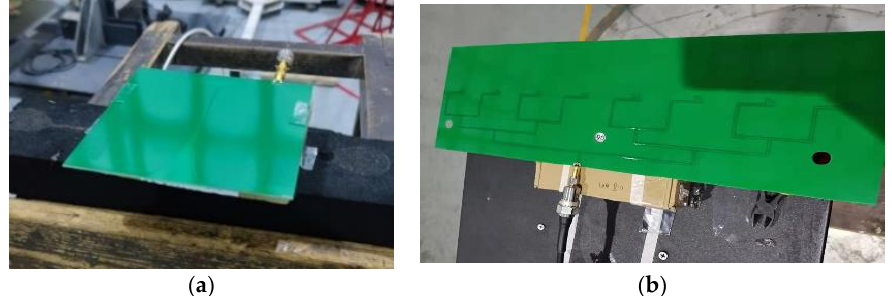
Figure 10. Photos of the proposed antennas. ( a ) Wide beam transmitting antenna. ( b ) Narrow beam receiving antenna.